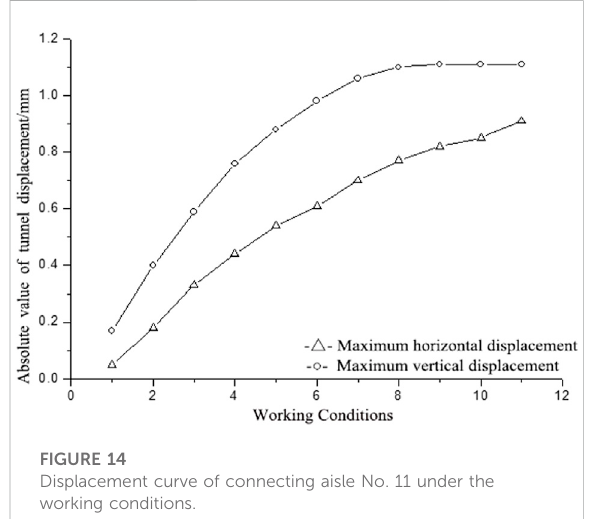
FIGURE 14 Displacement curve of connecting aisle No. 11 under the working conditions.